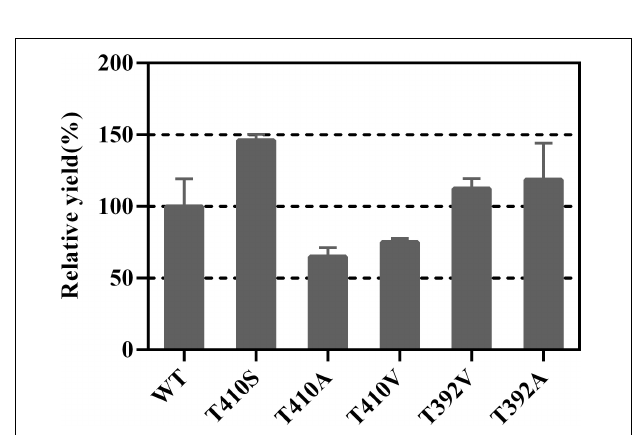
FIGURE 4 | The relative yields of T410 and T392 mutants compared with WT.